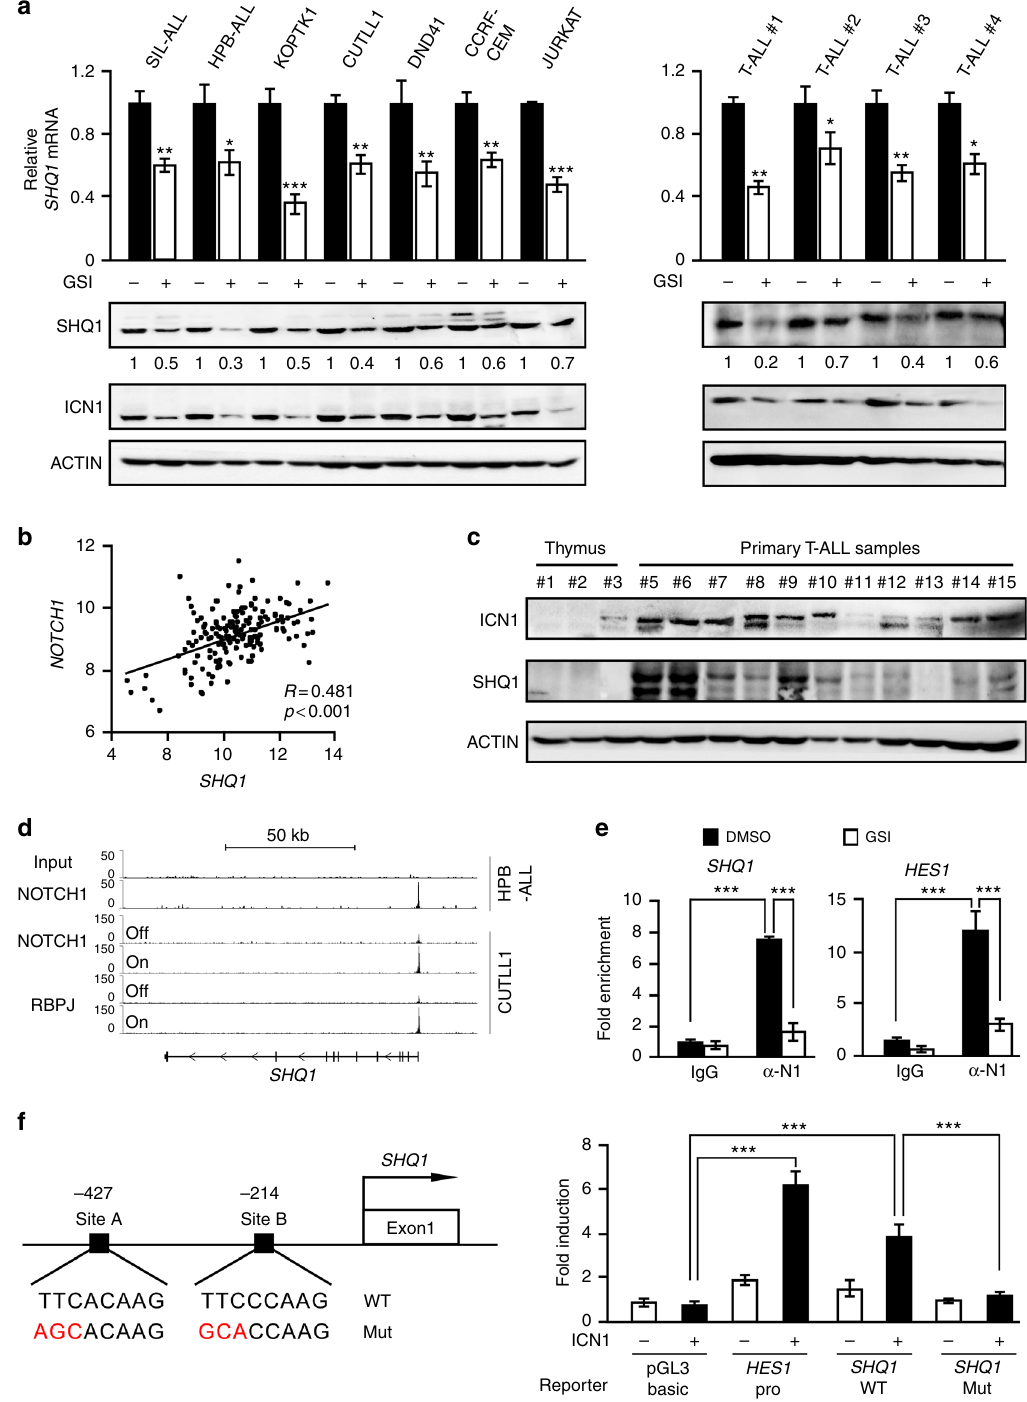
Fig. 2 Intracellular NOTCH1 directly binds to and activates SHQ1 . a Seven T-ALL cell lines and four primary T-ALL cells were subjected to GSI (Compound E, 1 μ M) or DMSO treatment for 24 h. SHQ1 mRNA and protein levels were subsequently determined by quantitative polymerase chain reaction (qPCR) and immunoblots. b Correlation of SHQ1 expression with NOTCH1 in 174 primary T-ALL samples (GSE13159) with mRNA levels presented as log2 median- entered intensity. Pearson ’ s correlation coef fi cient ( R ) = 0.481, p < 0.001, paired t -test. c Immunoblots of SHQ1 and ICN1 in additional 11 primary T-ALL and 3 normal thymus samples. d Chromatin landscapes around the SHQ1 locus in HPB-ALL (GSE58406) and CUTLL1 (GSE51800) cells. The associations of nuclear NOTCH1 and RBPJ with the SHQ1 transcriptional start region are shown with respect to NOTCH1 active or inactive state. e Binding of ICN1 to the SHQ1 or HES1 promoter was analyzed by ChIP in SIL-ALL cells with or without GSI treatment (Compound E, 1 μ M) for 24 h. Averages of fold enrichment between ICN1 and isotype IgG are shown. α -N1 denotes antibodies against ICN1. f Schematic presentation of two potential RBPJ-binding sites proximal to the SHQ1 transcription initiation site. Luciferase assays were carried out with SHQ1 DNA sequence ( − 441 to − 194) or HES1 promoter cloned into pGL3-basic vector; reporter activities relative to empty pGL3 vector without ICN1 are presented as average fold induction. Data shown represent the means ( ± SEM) of three biological replicates; * p < 0.05, ** p < 0.01, *** p < 0.001, unpaired t -test ( a , e , f